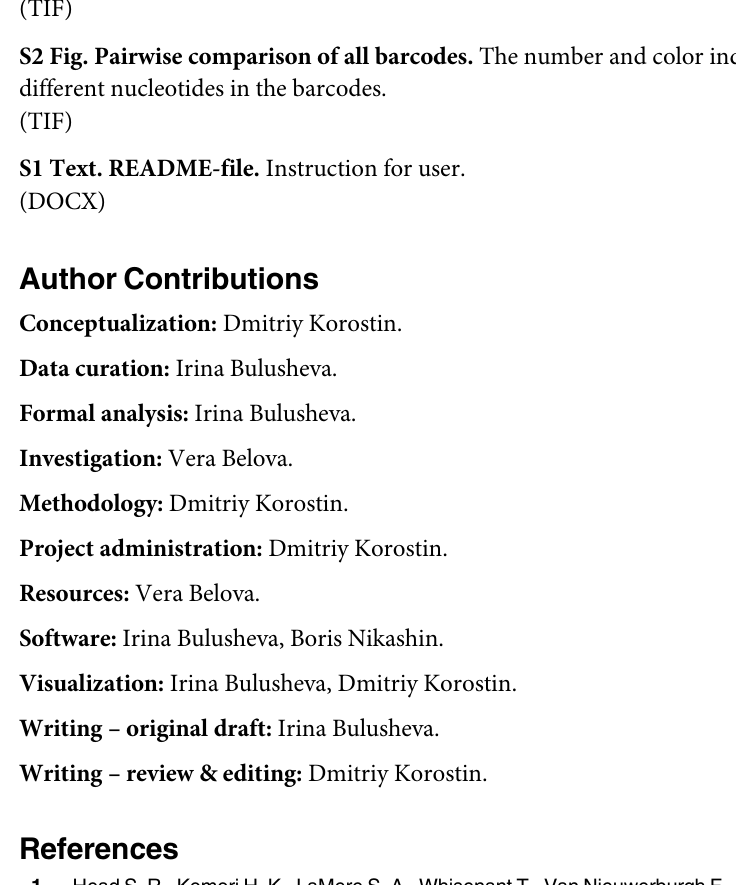
S1 Fig. Pairwise comparison of 63 barcodes. The number and color indicate the number of different nucleotides in the barcodes. The greater the difference, the more likely it is that sam- ples with these barcodes will not merge during sequencing. S2 Fig. Pairwise comparison of all barcodes. The number and color indicate the number of different nucleotides in the